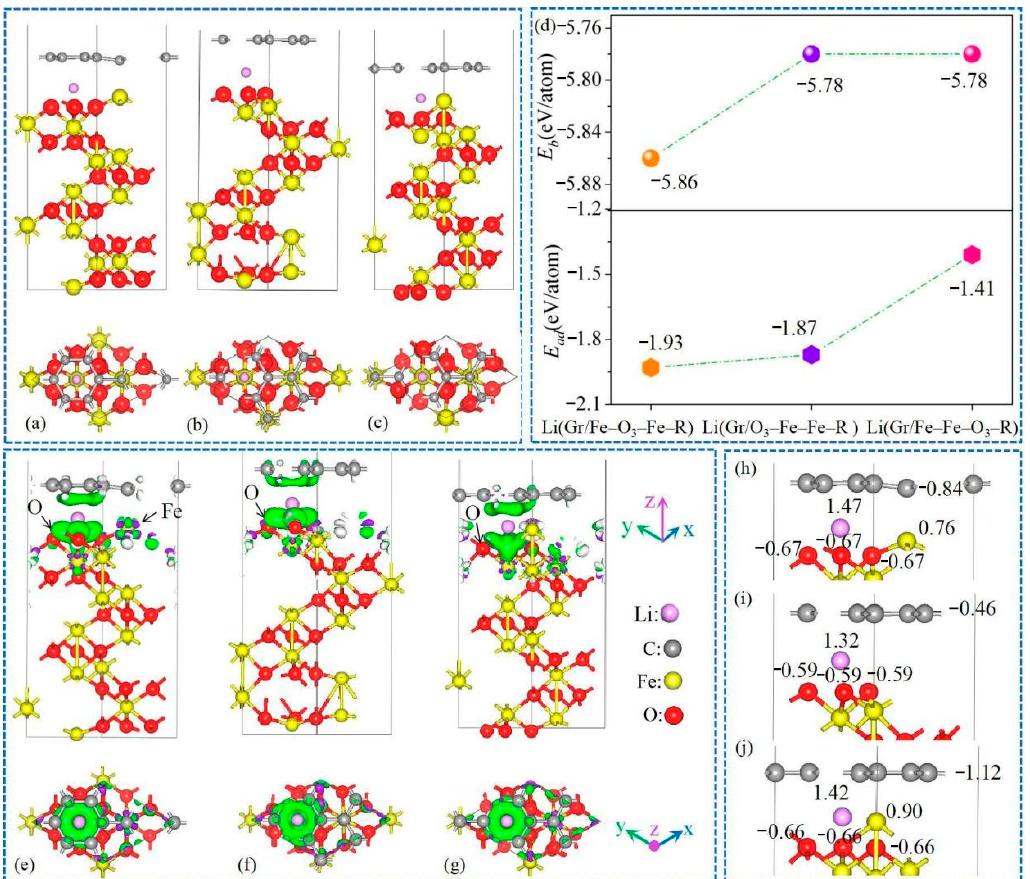
Figure 2. Optimized structures of ( a ) Li(Gr/Fe-O 3 -Fe-R), ( b ) Li(Gr/O 3 -Fe-Fe-R), and ( c ) Li(Gr/Fe-Fe-O 3 -R) heterostructures; ( d ) binding energy ( E b ), adsorption energy ( E ad ), and ( e – g ) charge difference plots of them (green and purple area represent density accumulation and depletion, isosurface level was set to 0.02 electrons/bohr 3 ); ( h – j ) transferred electrons of atoms near the interface in ( h ) Li(Gr/Fe-O 3 -Fe-R), ( i ) Li(Gr/O 3 -Fe-Fe-R), and ( j ) Li(Gr/Fe-Fe-O 3 -R) systems. E b and E ad of Li n (Gr/Fe-O 3 -Fe-R), Li n (Gr/O 3 -Fe-Fe-R), and Li n (Gr/Fe-Fe-O 3 -R) for dif-